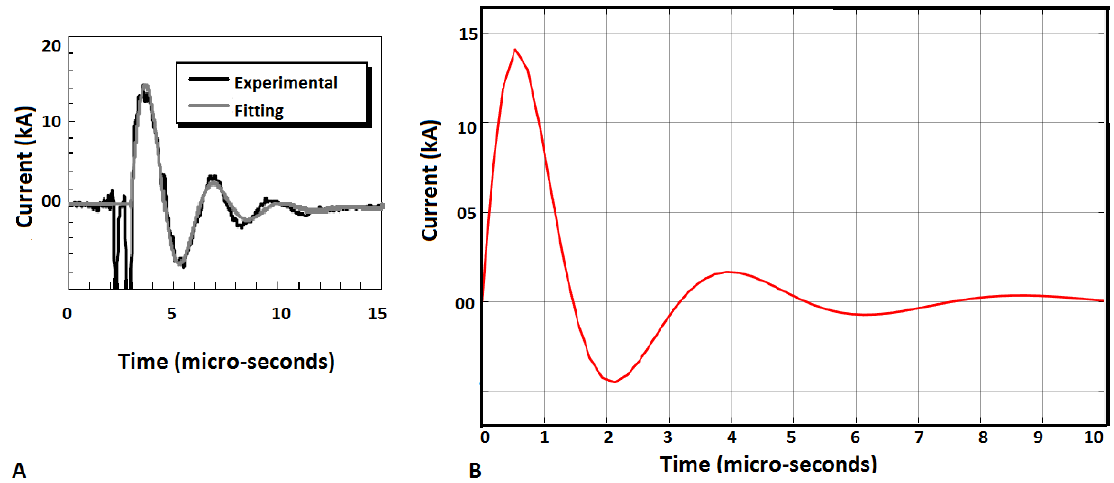
Figure 3. Discharge current waveform: ( A ) Experimental result [12]; ( B ) Simulation